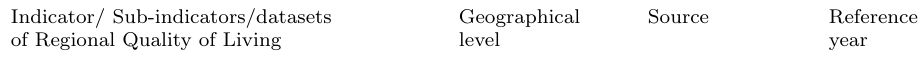
Table A.1: Additional information with respect to the data applied for the calculation of the Regional Quality of Life Index Indicator/ Sub-indicators/datasets